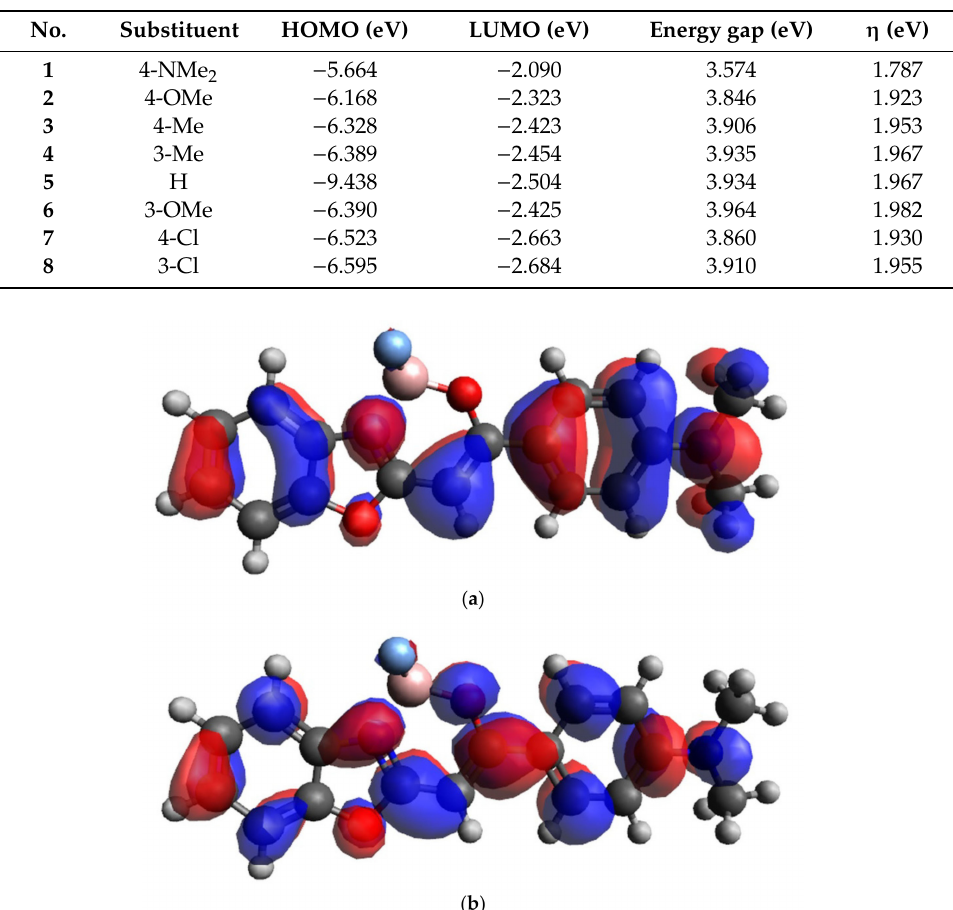
Figure 6. Distribution of HOMO ( a ) and LUMO ( b ) orbitals for 2-(4-dimethylamino)benzoyl- benzoxazole difluoroborane ( 1